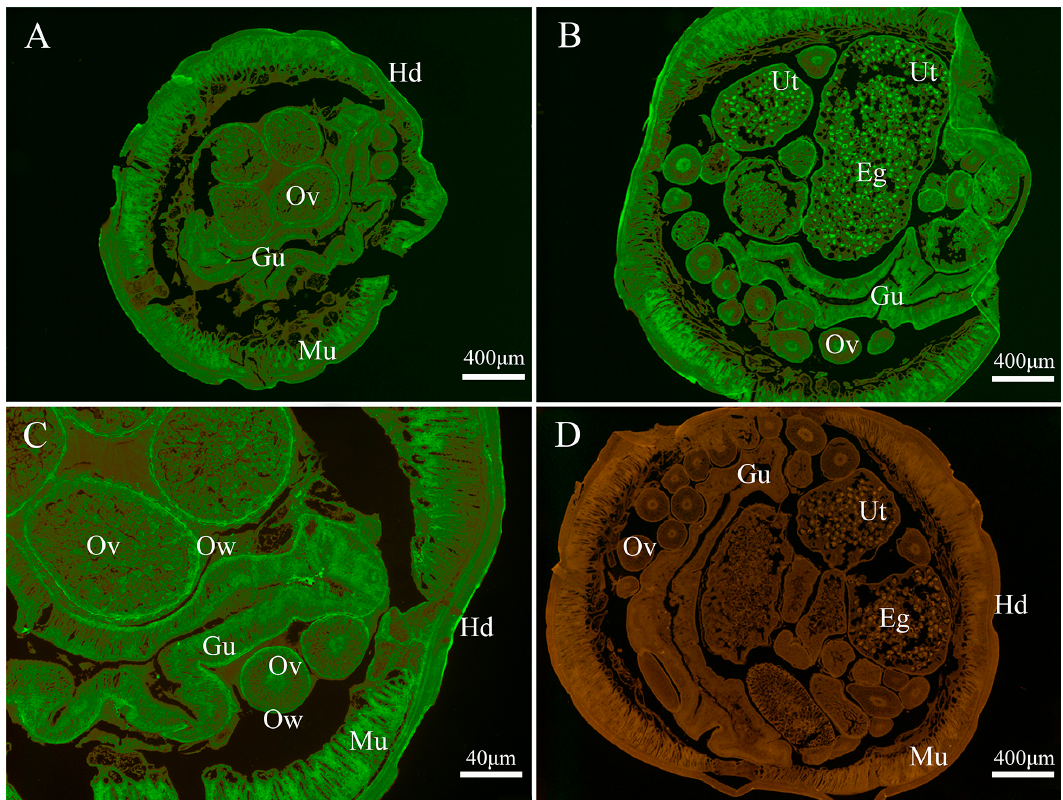
Figure 4. Immunolocalization of B. schroederi GAPDH (Bs -GAPDH). The sections (5- µ m thickness) were incubated with rabbit anti-recombinant Bs -GAPDH (anti-r Bs -GAPDH) IgG (1:100; panels A , B and C ), pre-immune rabbit IgG (1:100; panel D ). Panel C represented the magnified part of panel A. The endogenous Bs -GAPDH becomes visible with fluorescein isothiocyanate (FITC)-labeled goat anti-rabbit IgG (1:100). Abbreviations: Gu, gut; Mu, muscle; Ov, ovary; Hd, hypodermis; Ut, uterus; Eg, egg; Ow, ovarian wall.